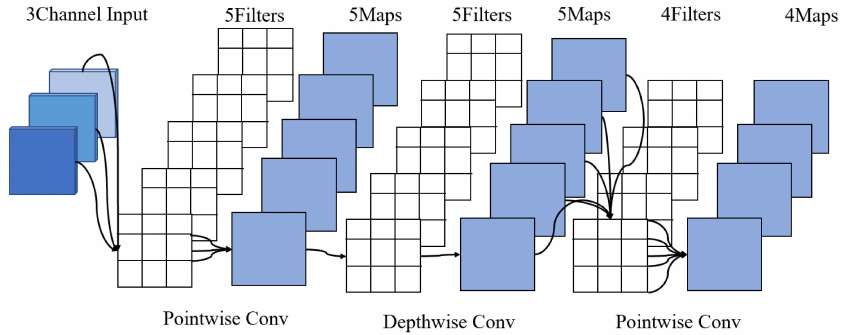
Figure 2. Convolution process of MobileNetV2.